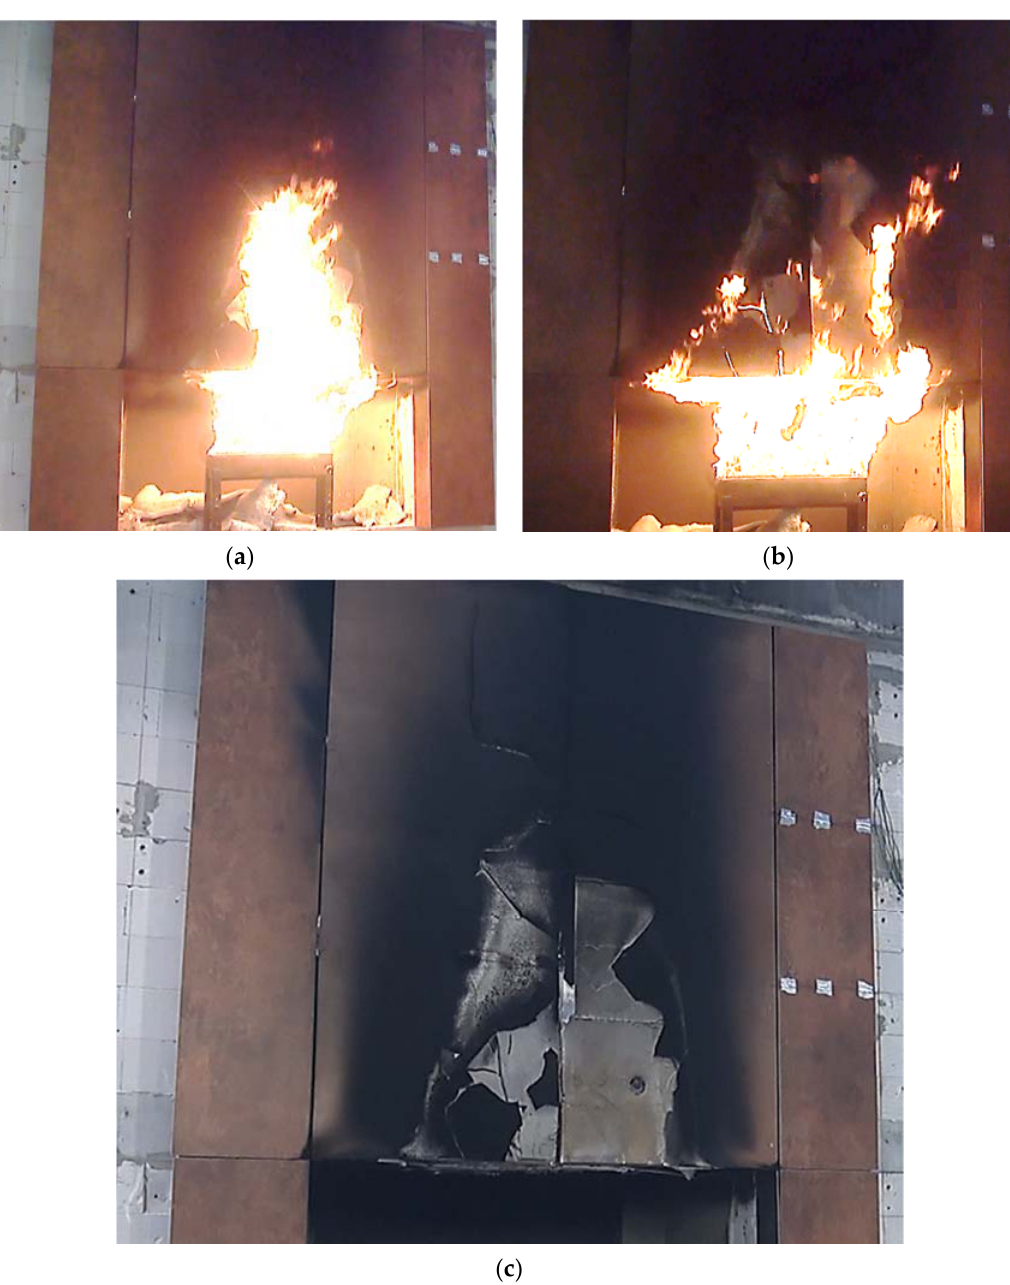
Figure 7. View of the large-scale facade model in the subsequent minutes of the test: ( a ) approximately 40’00”—high cladding degradation; ( b ) approximately 55’00”—more elements are falling off; ( c ) view of facade cladding after testing.